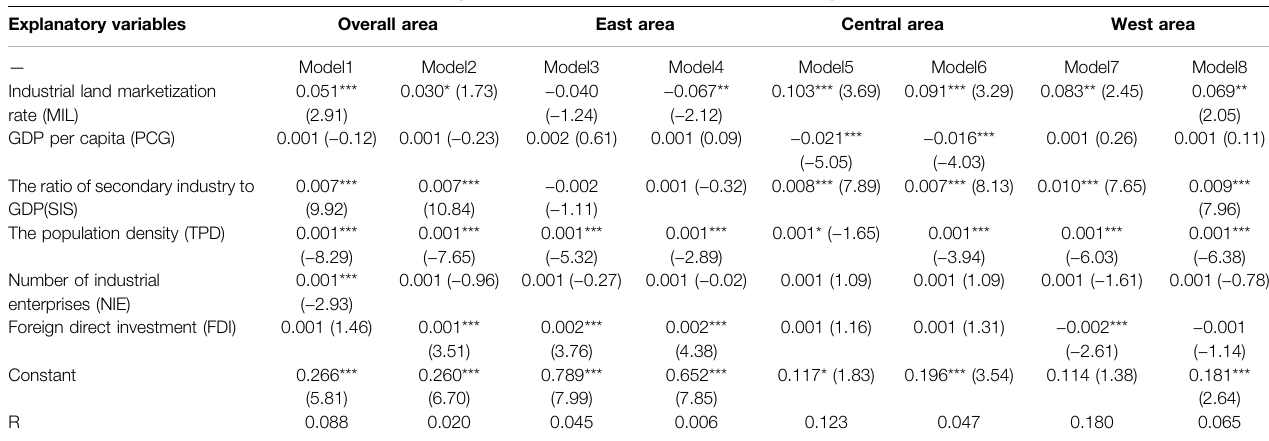
TABLE 2 | Impacts of MRIL on the